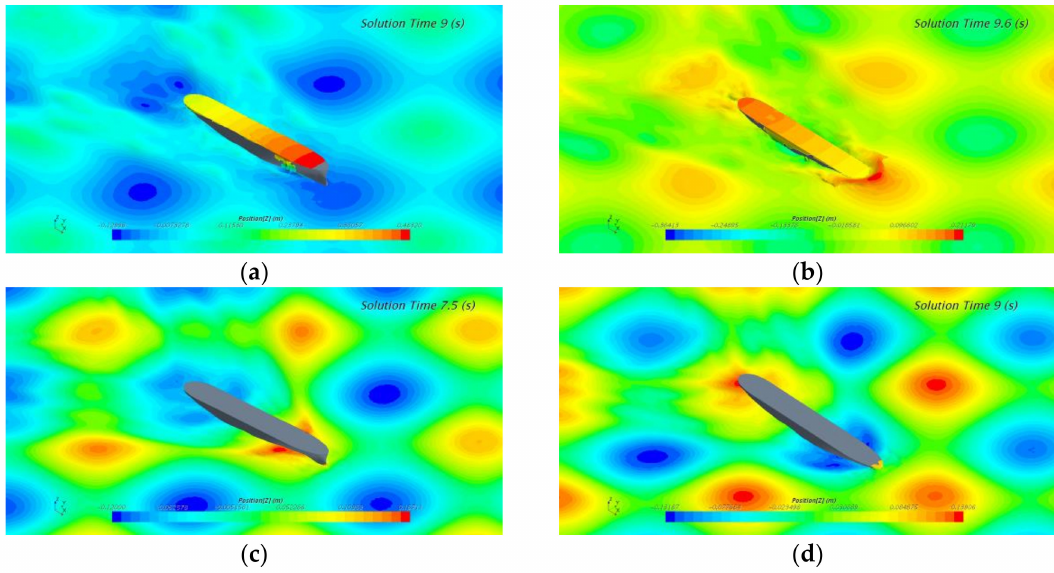
Figure 19. Comparative view of ship green water on deck at bow emergence and down phases: ( a ) 0 ◦